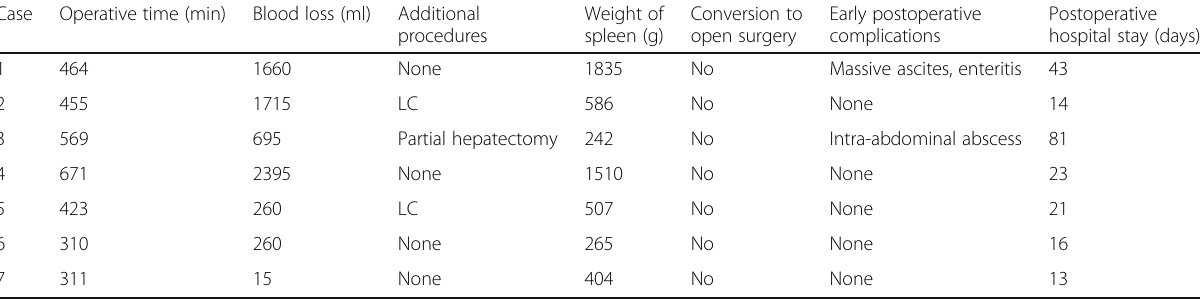
Table 2 Operative and postoperative data for seven patients